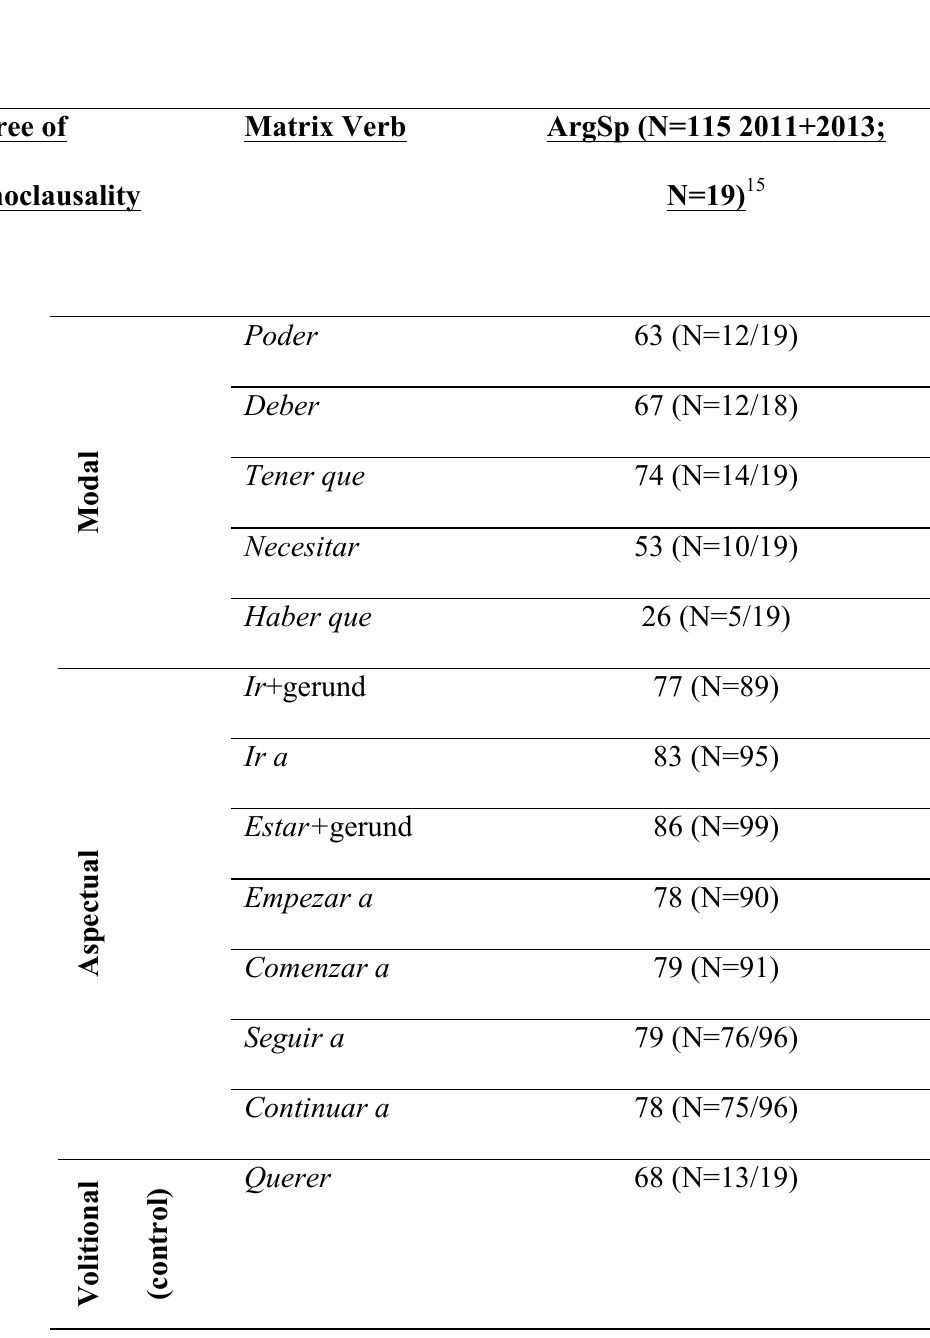
Table 13 . Is expansion of CC in ArgSp according to